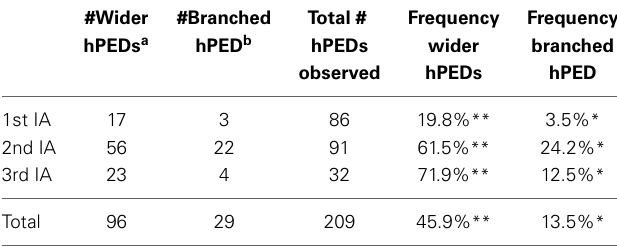
Table 1 | Frequency of initially wider or branched hPEDs in the first, second and third intercostal areas (IAs) of the first